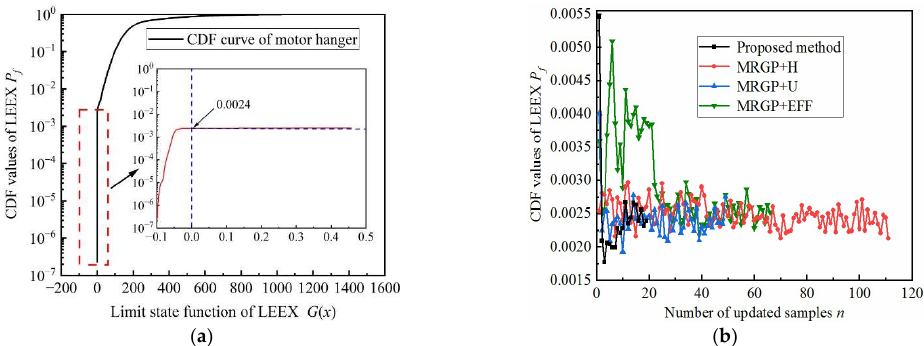
Figure 10. Reliability analysis results of LEEX under multiple failure modes. ( a ) CDF curve of IEEX; ( b ) Iterative curve of CDF. Table 5. Results of example 4.5 with different methods.